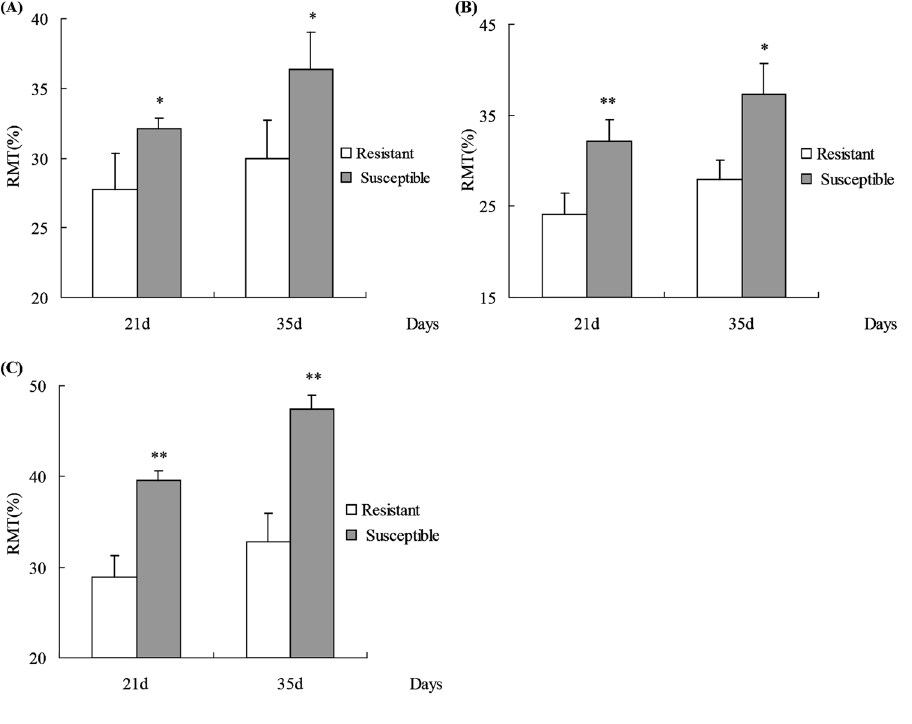
Figure 2. Relative medial thicknesses (RMT) of pulmonary arterioles of resistant and susceptible groups. ( A ) 100–200 μ m; ( B ) 50–100 μ m; ( C ) 20–50 μ m. Data are mean ± standard deviation (SD). ** P < 0.01 and * P < 0.05.